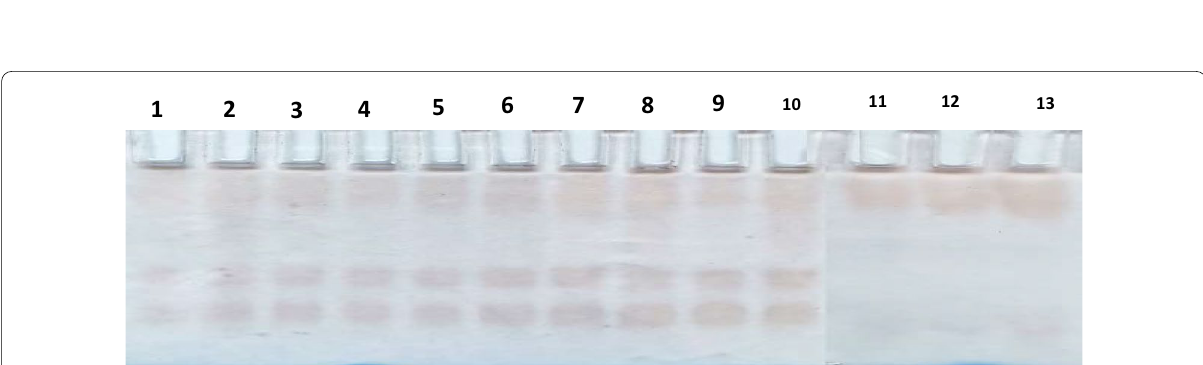
Fig. 3 Electrophoretic patterns of the polyphenol oxidase isozymes for the 13 rice genotypes under normal conditions. Lane 1: 8 and lane 9: 13 the highest five hybrids, respectively =